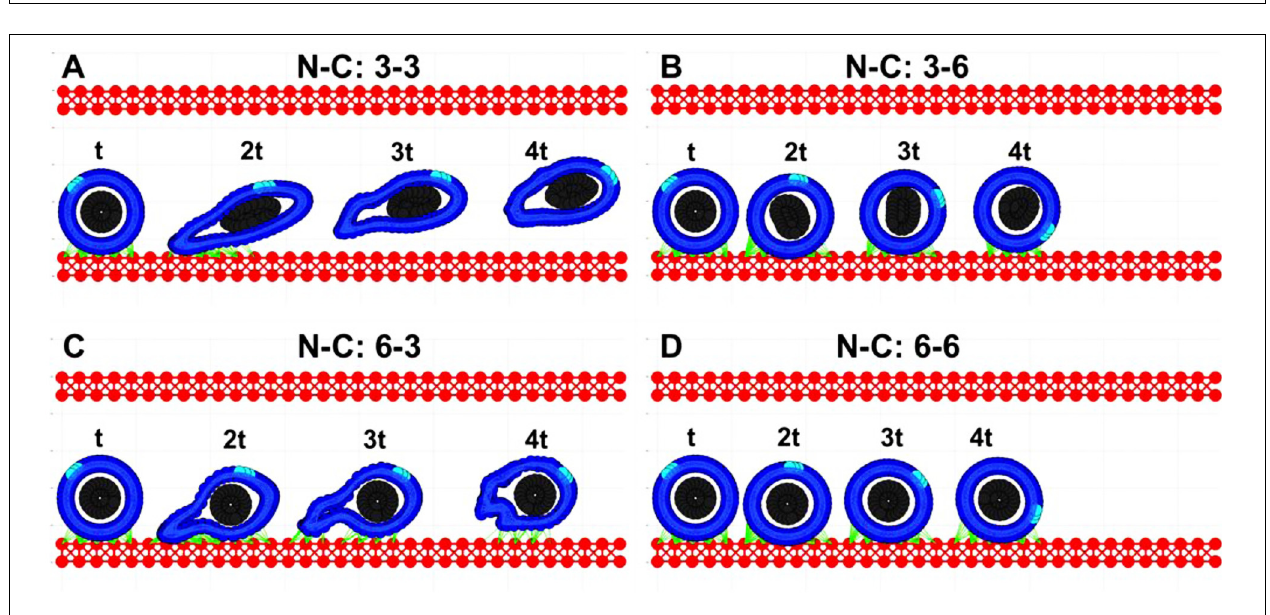
FIGURE 3 | Circulating tumor cell rolling on the endothelium. Each of the four cases (A–D) is characterized by a different cortex C and nucleus N stiffness value, however the strength of all adhesive bonds is fixed. The values are reported similarly as in Figure 2 . (A) both the cortex and nucleus stiffness are 3-fold higher than the baseline; (B) the nucleus stiffness is 3-fold and cortex stiffness is 6-fold higher than the baseline;